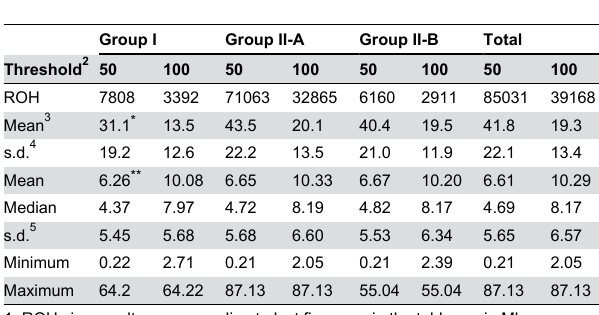
Table 1. ROH Detection and Size Statistics 1